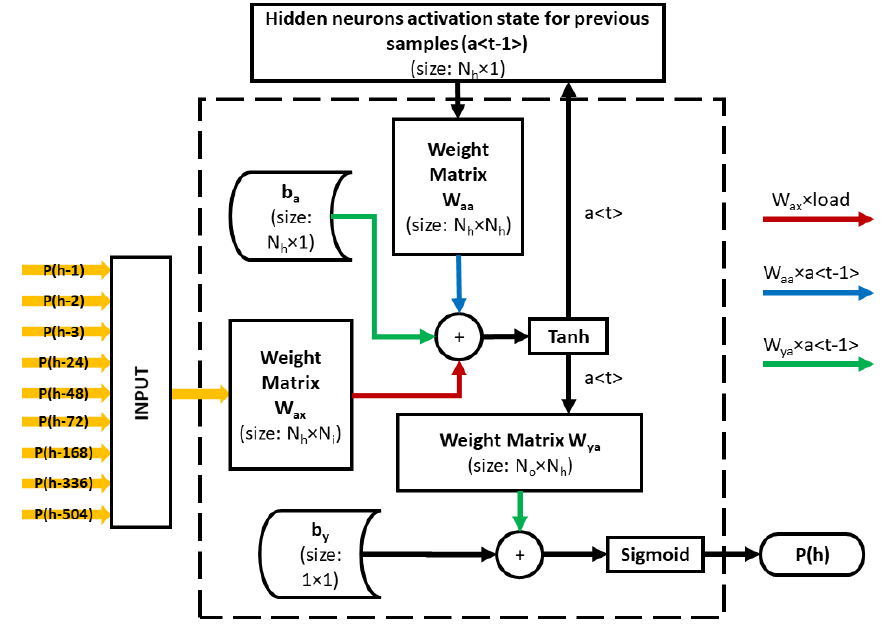
Figure 1. The considered